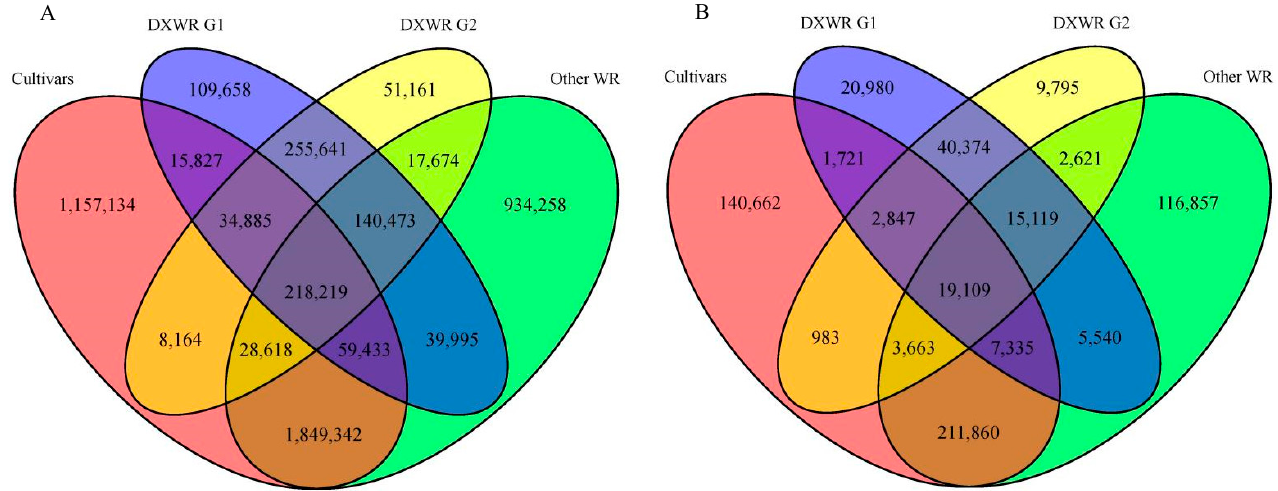
Figure 7. Venn of the two types of genetic variation ( A ) SNP and ( B ) InDel between wild rice (WR) from Dongxiang (DX), WR from other regions, and cultivars. Cultivars: cultivated rice; Other WR: other common wild rice; WRDX G1: G1 subpopulations of DXWR; WRDX G2: G2 subpopulations of DXWR.